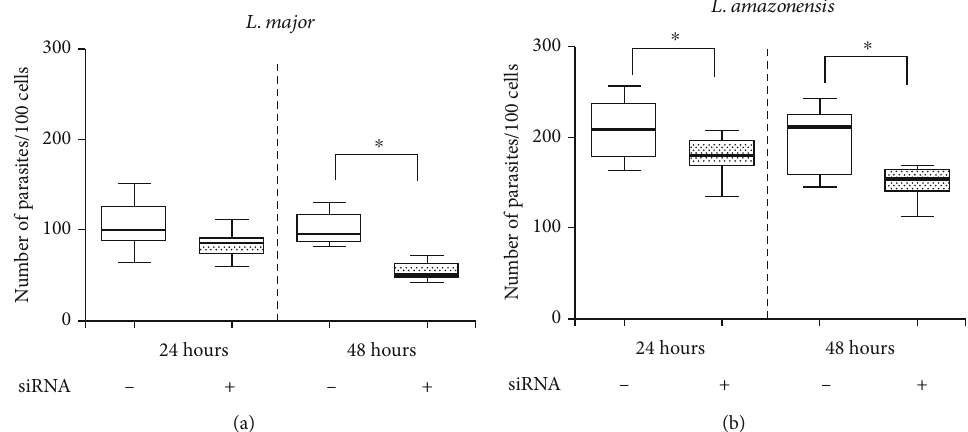
Figure 5: Parasitism in L. major - or L. amazonensis -infected macrophages upon IGF-I siRNA transfection. RAW 264.7 cells infected with L. major or L. amazonensis promastigotes transfected with or without 150 μ M IGF-I siRNA for 6 hours. The parasitism (median number of parasites per 100 cells) was evaluated after 24 and 48 hours. One representative experiment from three independent assays is shown. ∗ p < 0 : 05 (ANOVA and Tukey ’ s